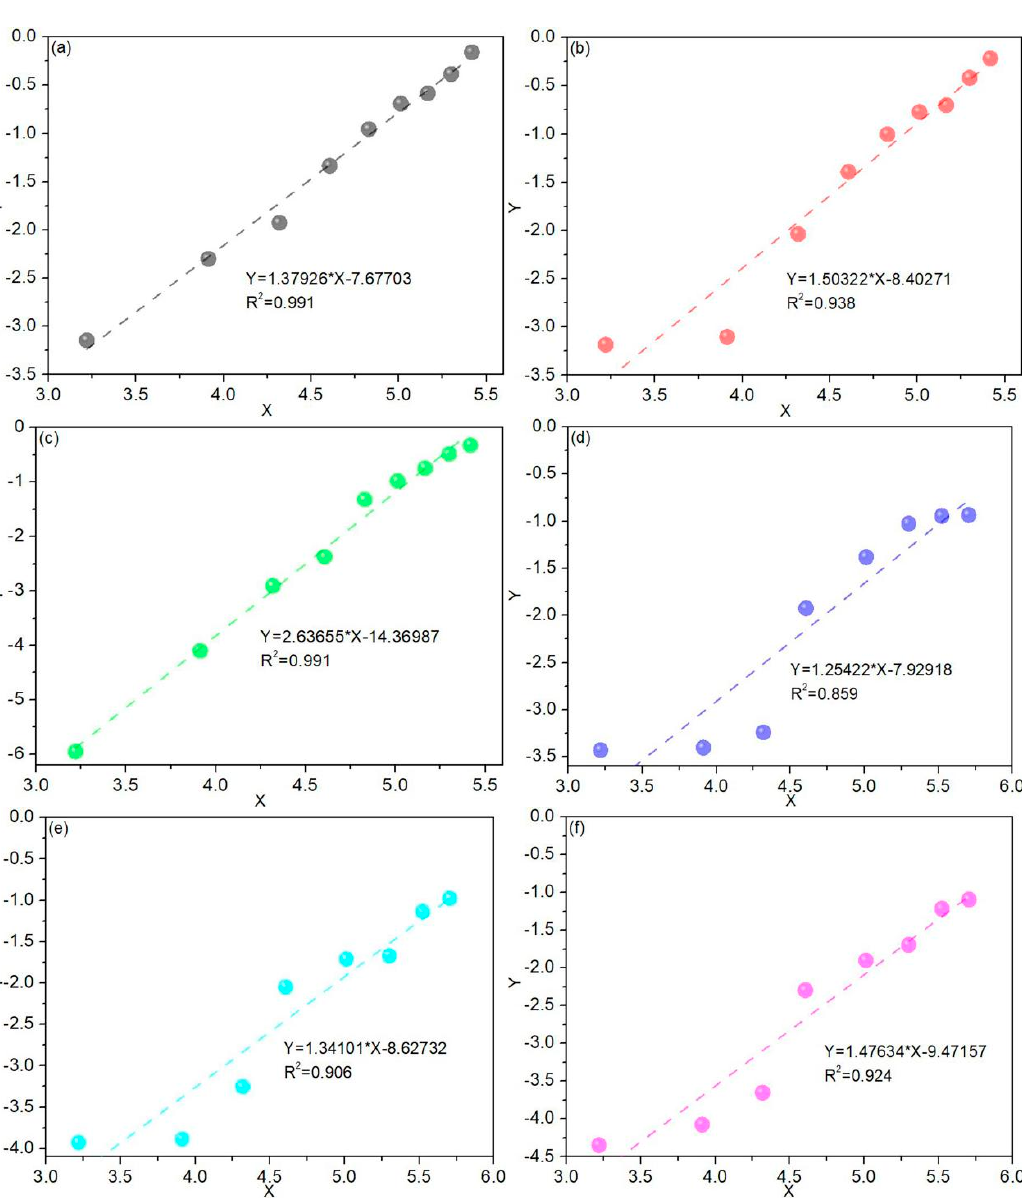
Figure 8. Graphical analysis of the freeze–thaw damage for: ( a ) CD0-L; ( b ) CD3-L; ( c )